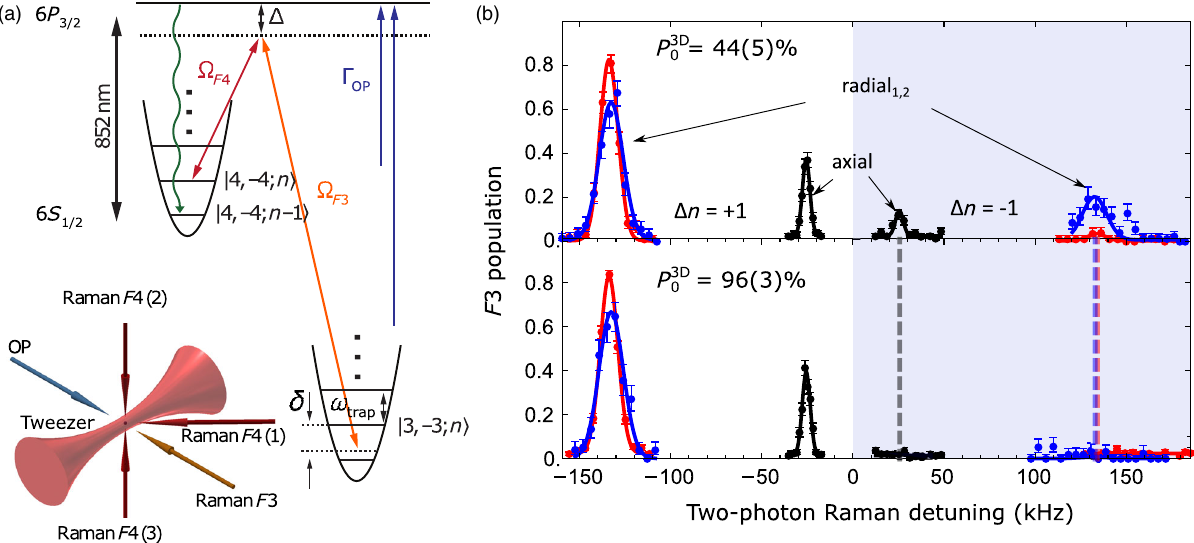
FIG. 2. 3D motional control of a single Cs atom. (a) Level scheme for Cs RSC. F 3 and F 4 Raman beams coherently couple adjacent motional states to reduce motional energy, while optical pumping provides the dissipation needed for cooling. Inset: Directions of laser beams. Switching Raman F 4 beam directions allows addressing motion in all three dimensions. (b) 3D sideband thermometry for Cs after RSC. Black, blue, and red spectral peaks in the unshaded (shaded) region correspond to Δ n ¼ þ 1 ( − 1 ) sidebands for the axial and two radial directions, respectively. Top: Spectra after suboptimal RSC reveals the Δ n ¼ − 1 sidebands, and hence the motional frequencies. The 3D ground-state population is P 3 D 0 ¼ 44 ð 5 Þ % . Bottom: Spectra after cooling with optimized motional frequencies, yielding P 3 D 0 ≥ 96 ð 3 Þ %